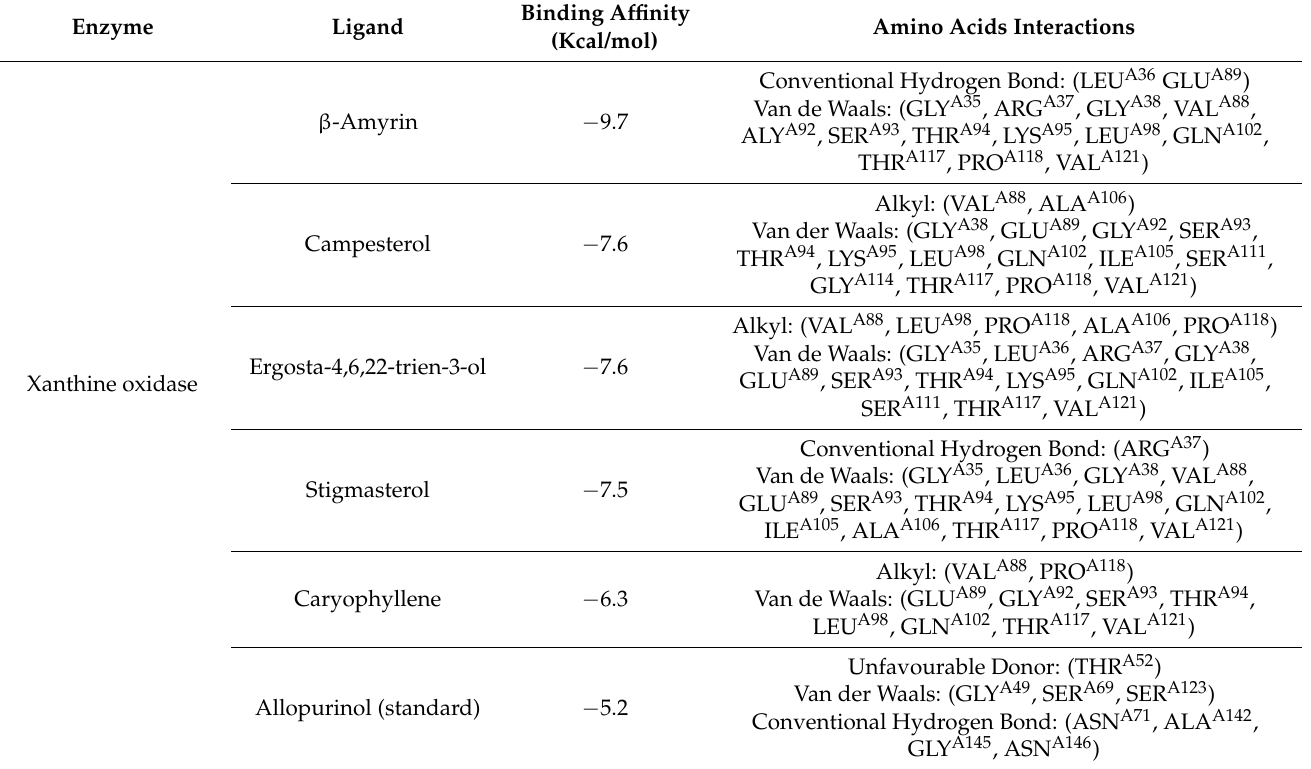
Figure 6. Three ‐ dimensional structured molecular interactions of Caryophyllene ( A ), β‐ Amyrin ( B ), Stigmasterol ( C ), Ergosta ‐ 4,6,22 ‐ trien ‐ 3 ‐ ol ( D ), Campesterol ( E ), and Allopurinol (standard) ( F ) with Xanthine oxidase enzyme. Table 7. Binding affinities and interactions of the selected phytocompounds identified by GC ‐ MS from N. procumbens n ‐ hexane fraction against xanthine oxidase enzyme.